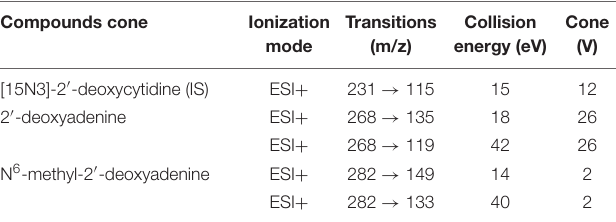
TABLE 1 | MS/MS parameters for MRM detection of modified and unmodified hydrolyzed nucleosides. Compounds cone Ionization